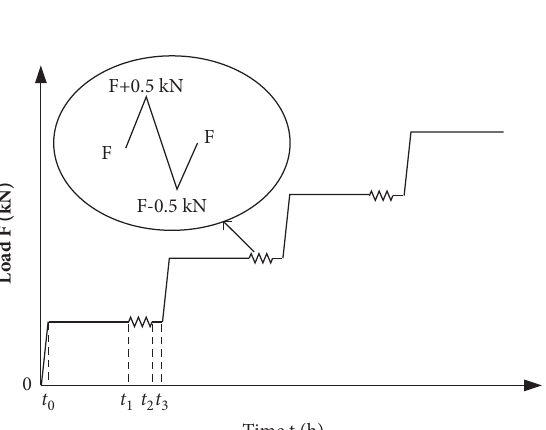
− t 1 is the specified load stabilization time;